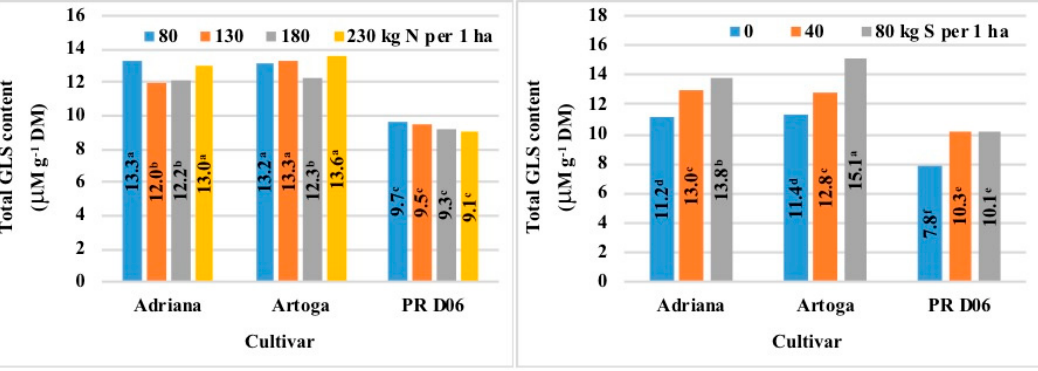
Figure 13. The e ff ect of N and S rates on the total glucosinolates (GLS) content of winter oilseed rape seeds, across years. Means with the same letters do not di ff er significantly at p ≤ 0.05 in Tukey‘s test.